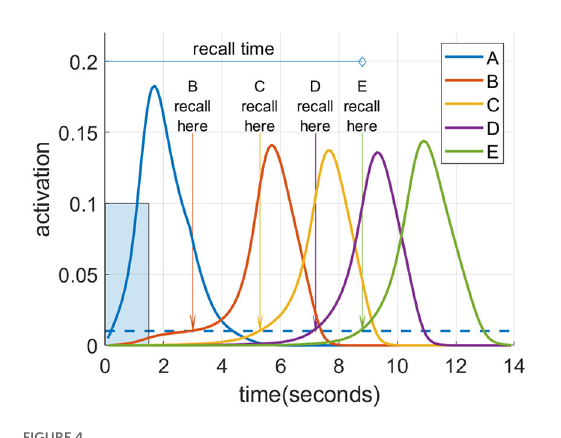
FIGURE4 Spreading activation recalls a cued sequence during waking. After multiple training exposures, a presentation of the “A” cue (input activation of 0.1 for 1.5 s shown as a blue rectangle) causes a recall cascade in the cortex due to spreading activation through causal links. Each item in the sequence is considered recalled when it reaches the recall threshold of 0.01, shown as the blue dotted